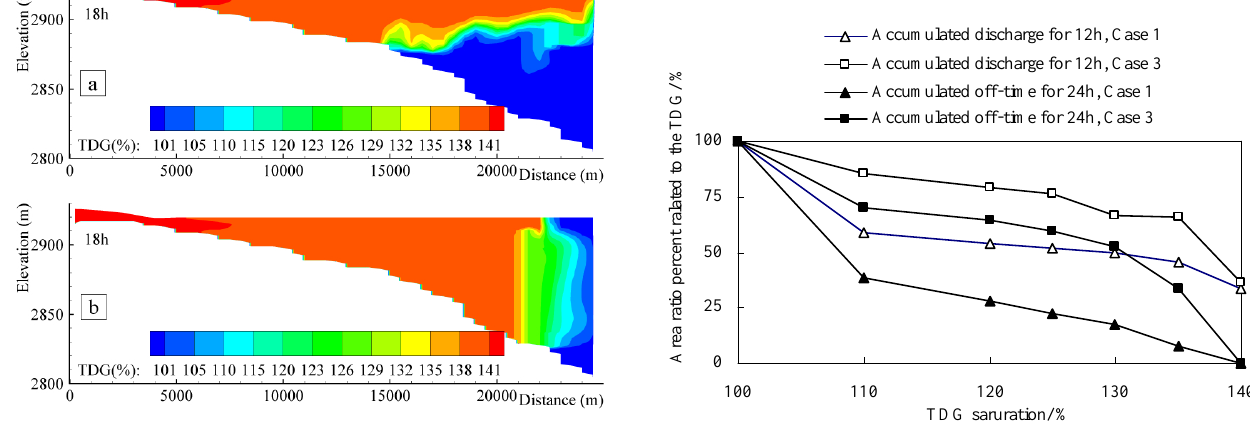
Fig. 16. Accumulated area ratio over TDG saturation